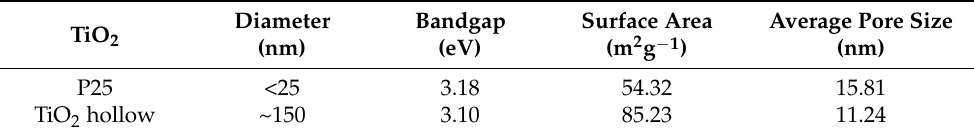
Table 1. Physical properties of P25 and TiO 2 hollow nanospheres.